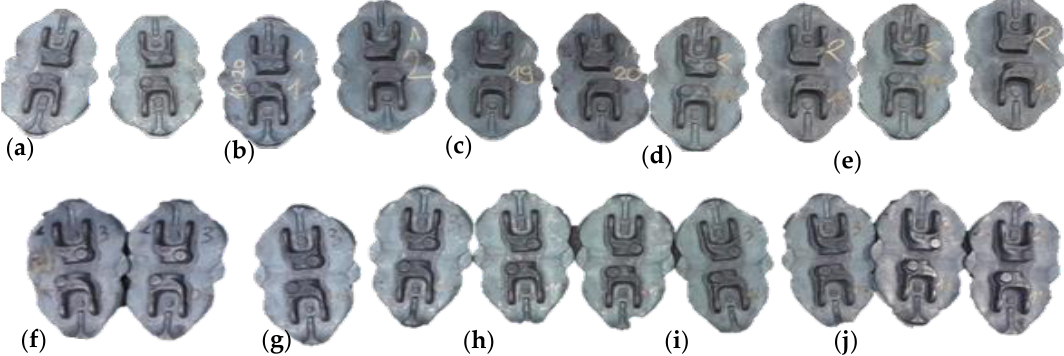
Figure 15. View of two consecutive forgings collected from the process: ( a ) the 100th and 101st item from series I, ( b ) the 200th and 201st item from series I, ( c ) the 300th and 301st item from series I, ( d ) the 400th and 401st item from series I, ( e ) the 500th and 501st item from series I, ( f ) the 100th and 101st item from series II, ( g ) the 200th and 201st item from series II, ( h ) the 300th and 301st item from series II, ( i ) the 400th and 401st item from series II, ( j ) the 500th and 501st item from series II.